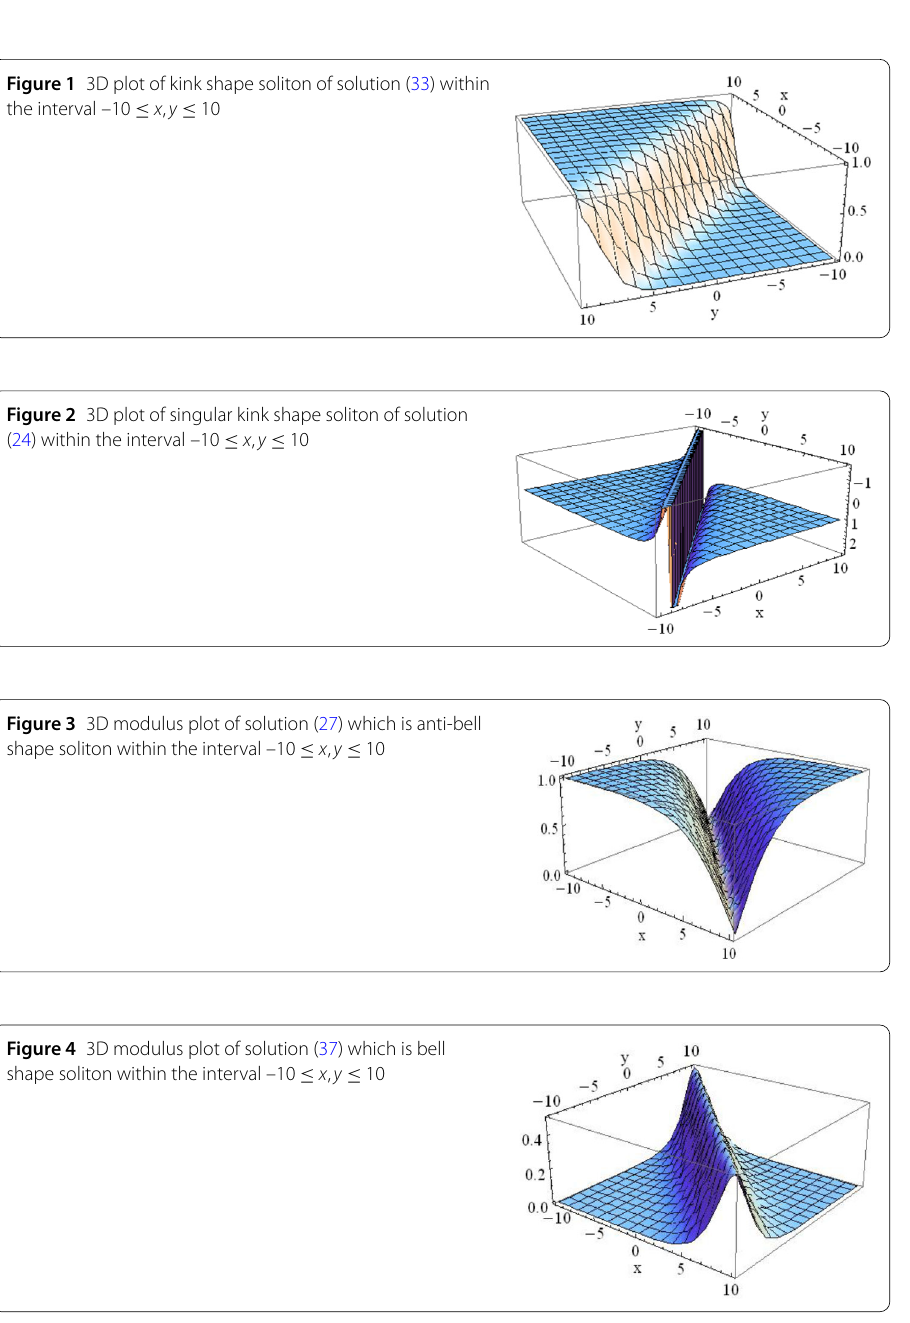
Figure 4 3D modulus plot of solution (37) which is bell shape soliton within the interval –10 ≤ x , y ≤